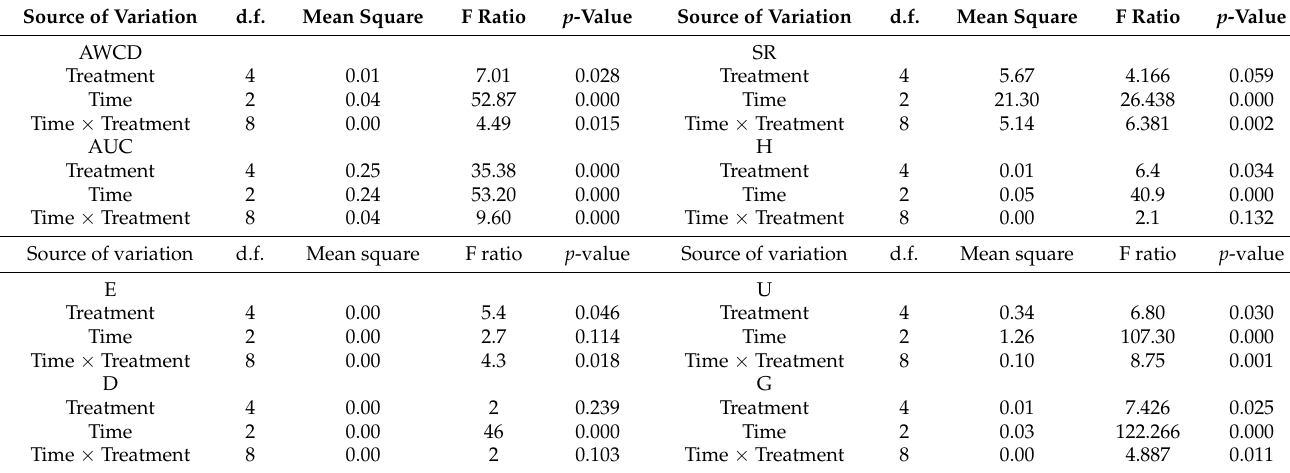
Figure 10. The effect of TiO 2 nanoparticles on the freshwater average well colour development value. Letters on the columns indicate significant differences (level of significance: p < 0.05). Table 3. RMANOVA results over time to evaluate effects of nTiO 2 treatment on the freshwater microbial diversity. Bold numbers indicate significant differences at p < 0.05.